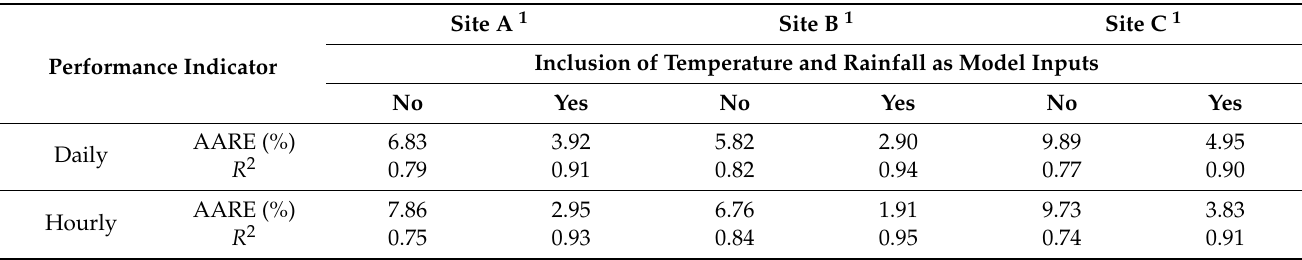
Table 6. Performance of ARMA models for the test data for the three study